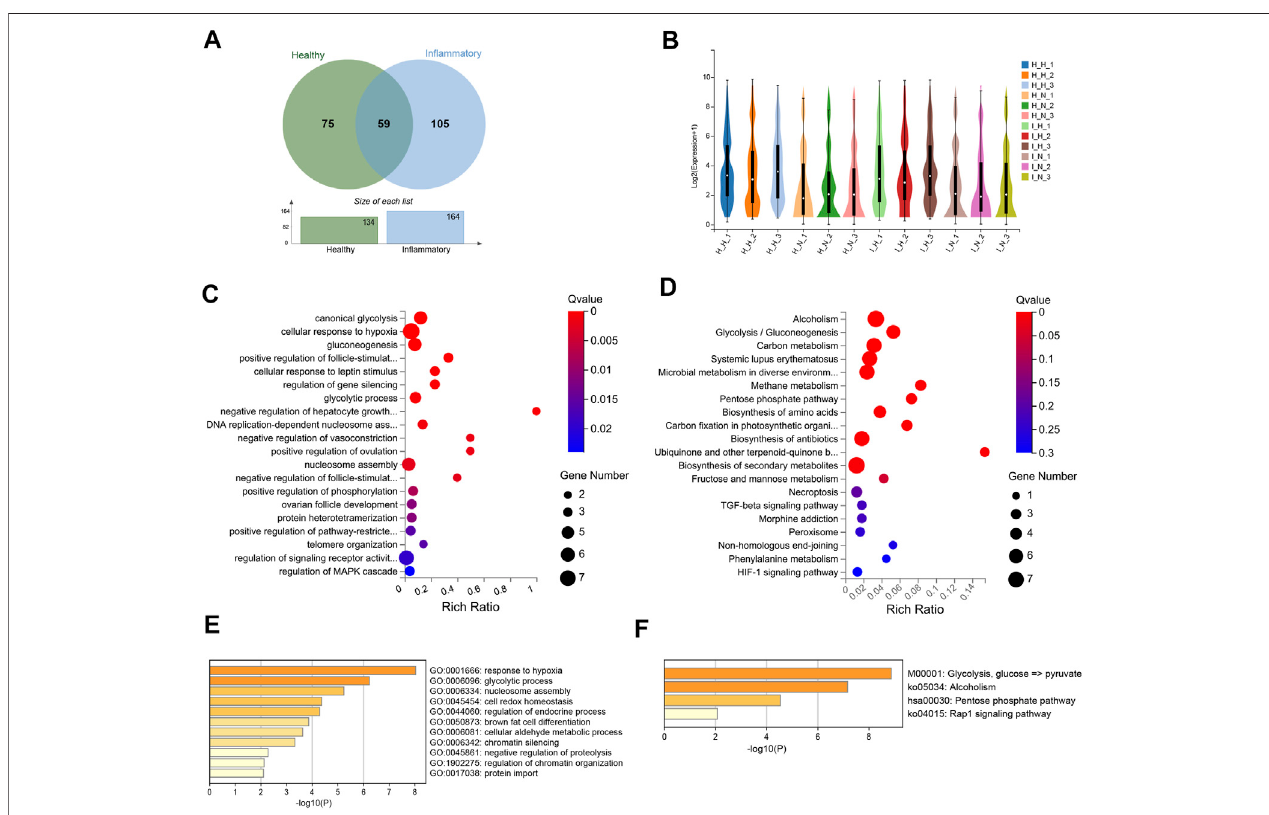
FIGURE 6 | Differentially expressed genes (DEGs) in both healthy and in fl ammatory hPDLSCs. (A) Venn diagram of the common DEGs. (B) Violin plot of gene expression foreachsample. (C) GeneOntology(GO)enrichmentanalysesoftheDEGs. (D) KyotoEncyclopediaofGenesandGenomes(KEGG)enrichmentanalysesof theDEGs. (E) BargraphoftheenrichedKEGGpathwaysdeterminedusingMetascape.Thepathwaysarecoloredaccordingtothe p value. (F) BargraphofenrichedGO biological processes identi fi ed using Metascape.